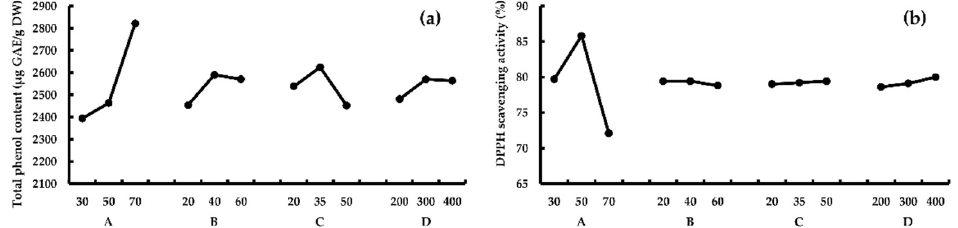
Figure 3. The effect of different UAE parameters on TPC ( a ) and AA ( b ). A, temperature ( ◦ C); B, time (min); C, ultrasonic frequency (kHz); D, ultrasonic power (Watt).